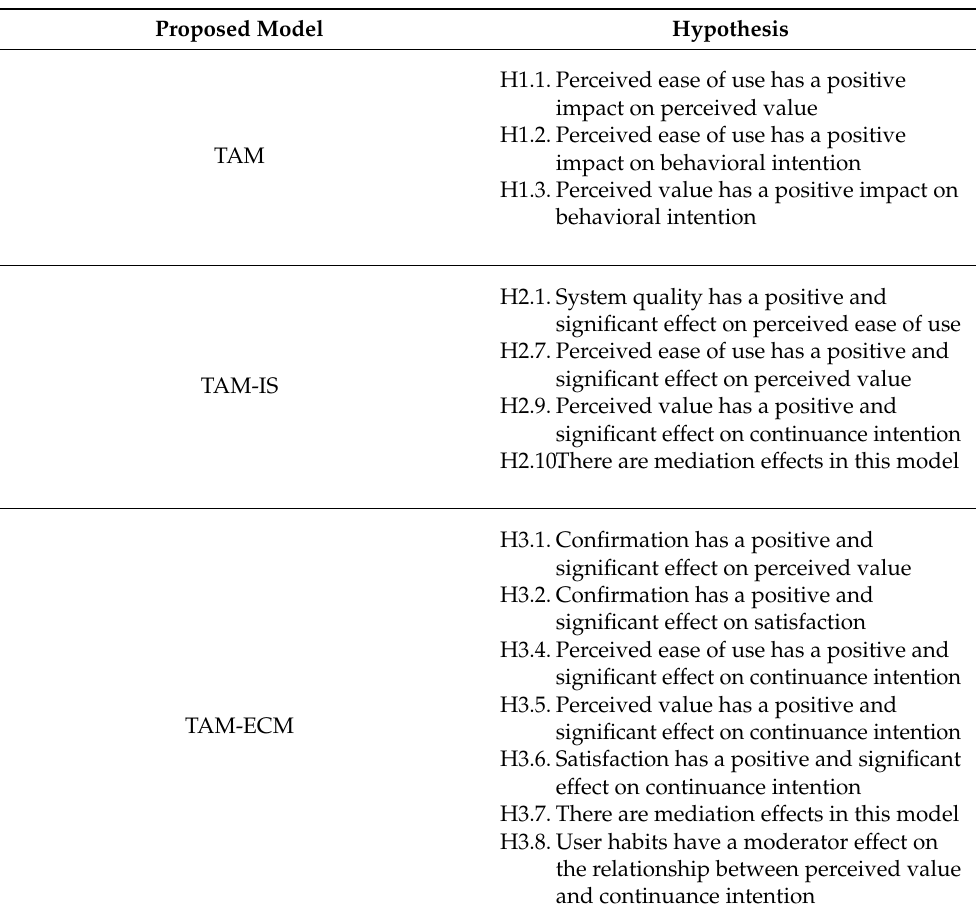
Table 9. Summary of the supported